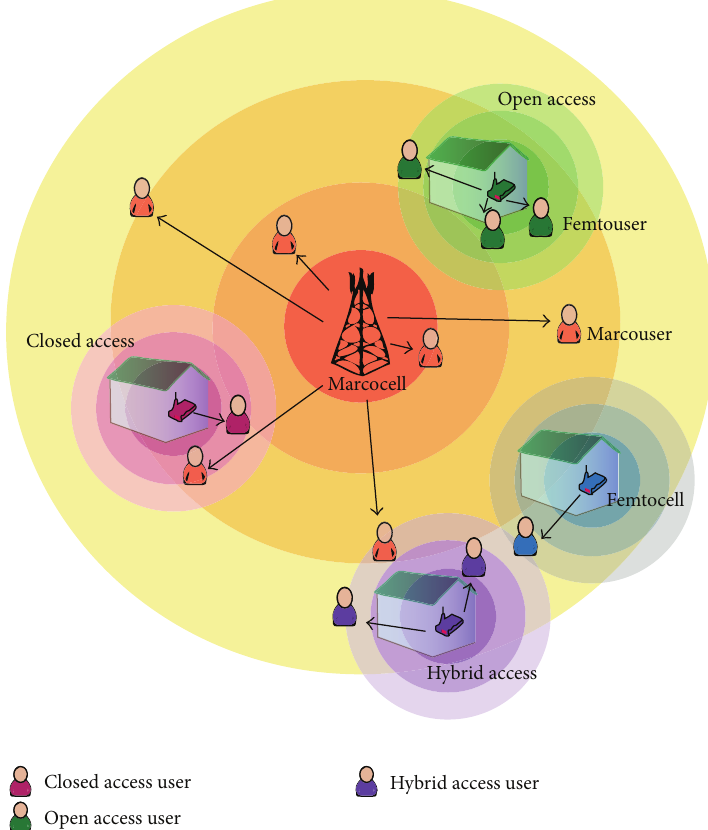
Figure 1: Different access control in mechanism femtocell